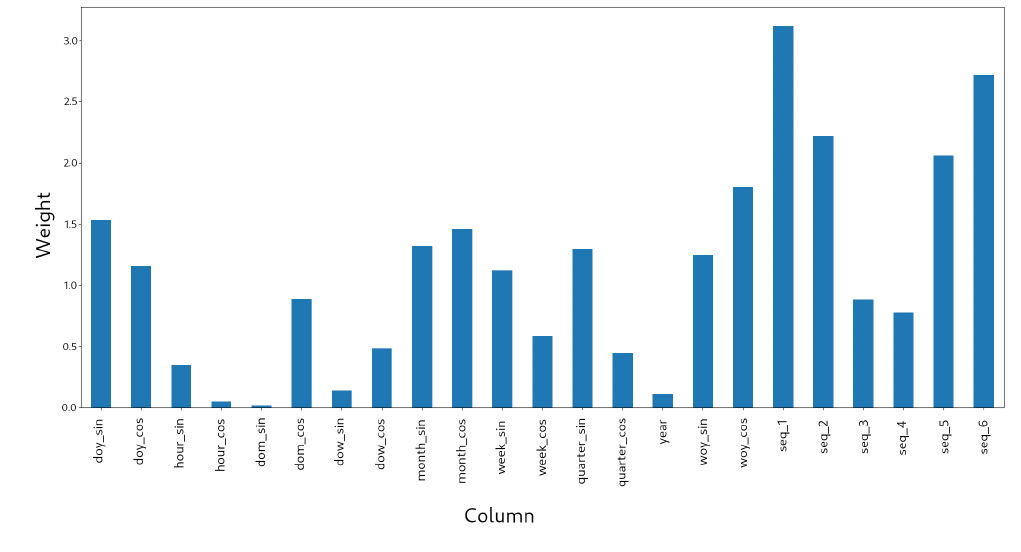
Figure 4. Model weights for the cyclic embedding with the sequence